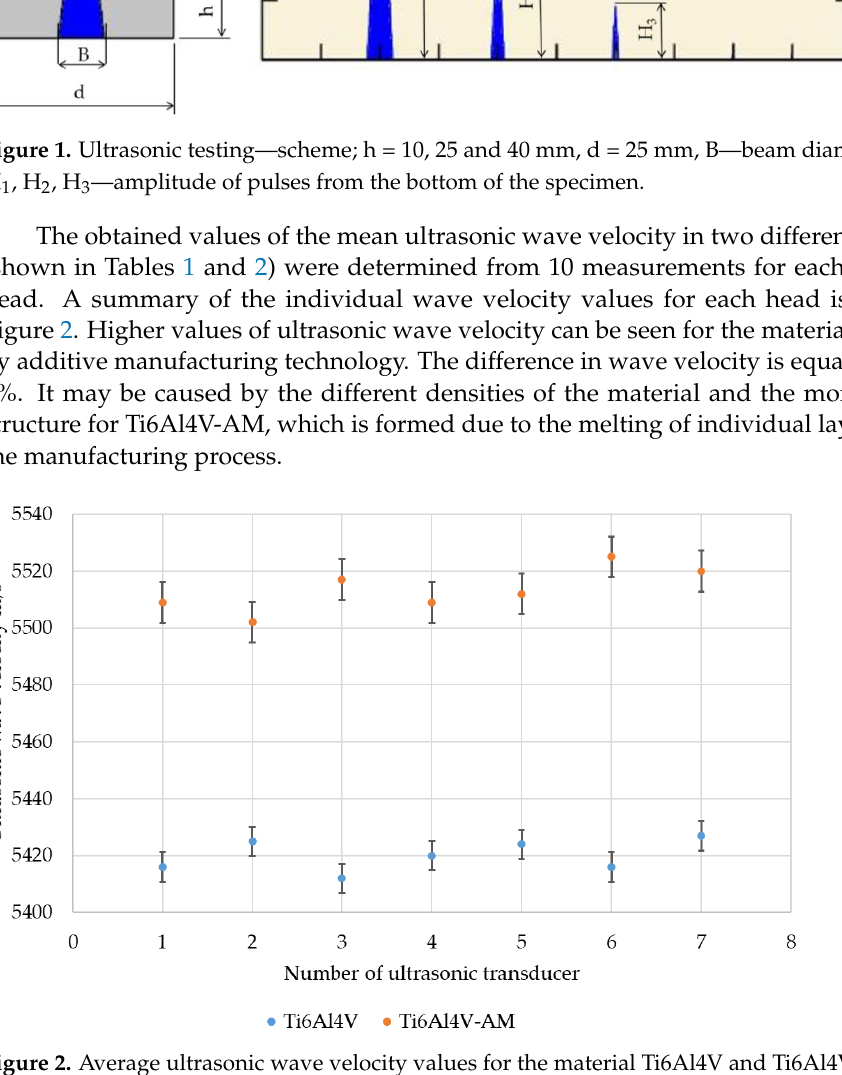
Figure 2. Average ultrasonic wave velocity values for the material Ti6Al4V and Ti6Al4V-AM.